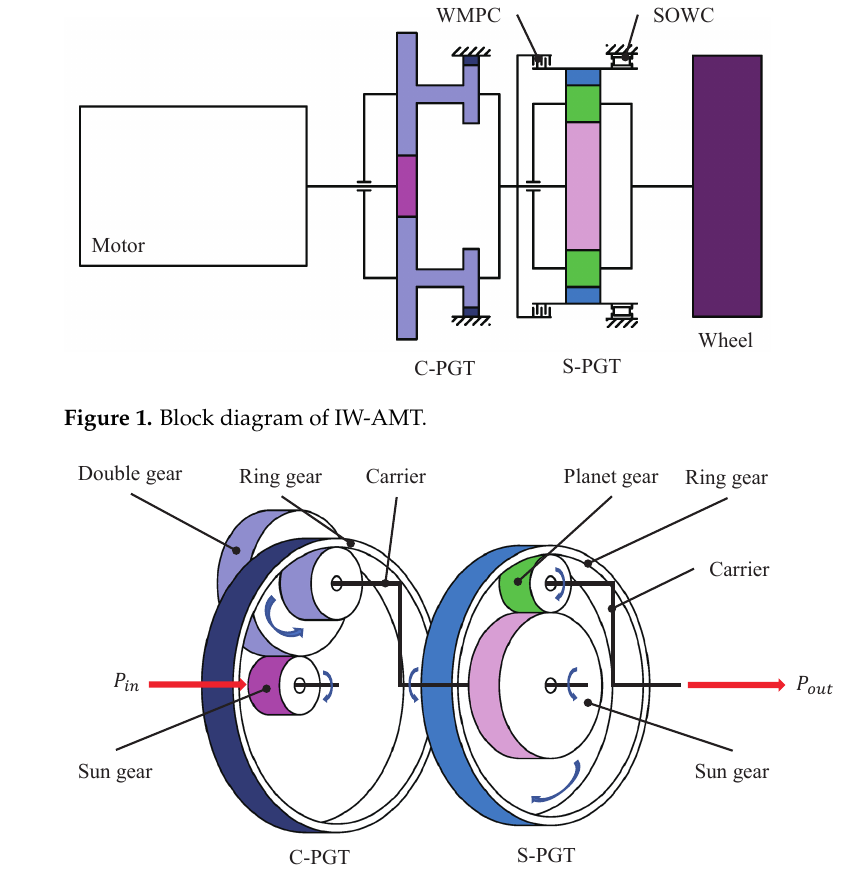
Figure 2. Block diagram of the planetary gear